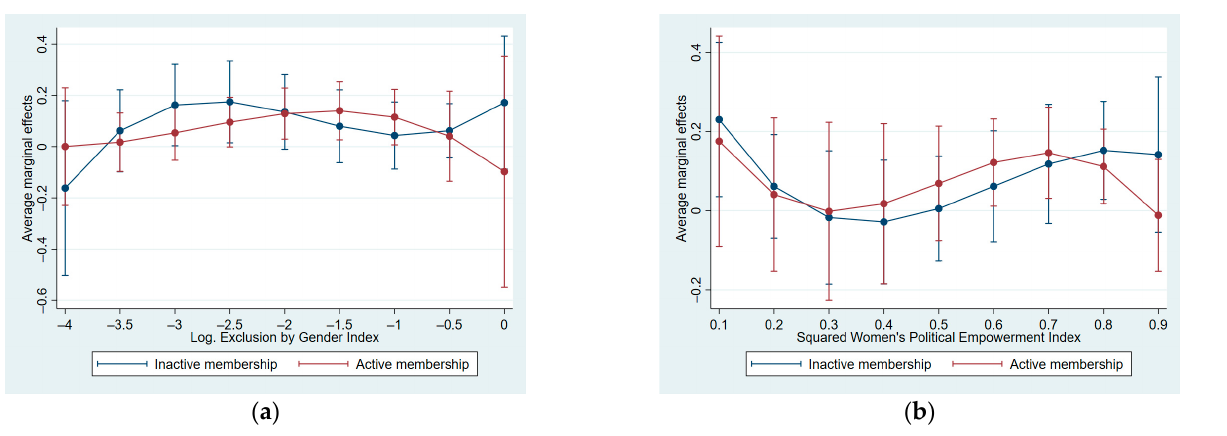
Figure A2. Average marginal effects for active and inactive membership in sports clubs on sexist gender ideologies conditioned on the log ‐ transformed EG Index ( a ), respectively, conditioned on the squared WPE Index ( b ). Results for the group of men. We included 95% confidence intervals using robust standard errors. Source: WVS ‐ EVS ‐ data and V ‐ Dem data.